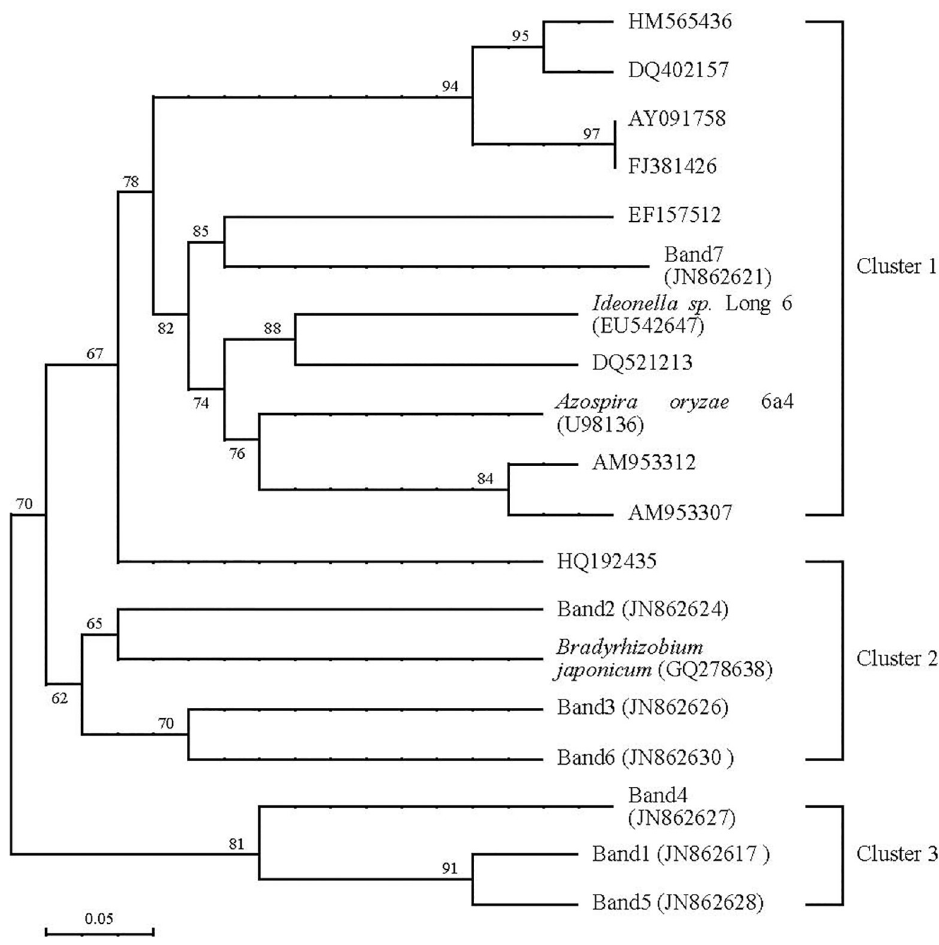
Fig 4. Phylogenetic tree of nifH gene in soil samples by using all OTUs identified with different long-term fertilizer